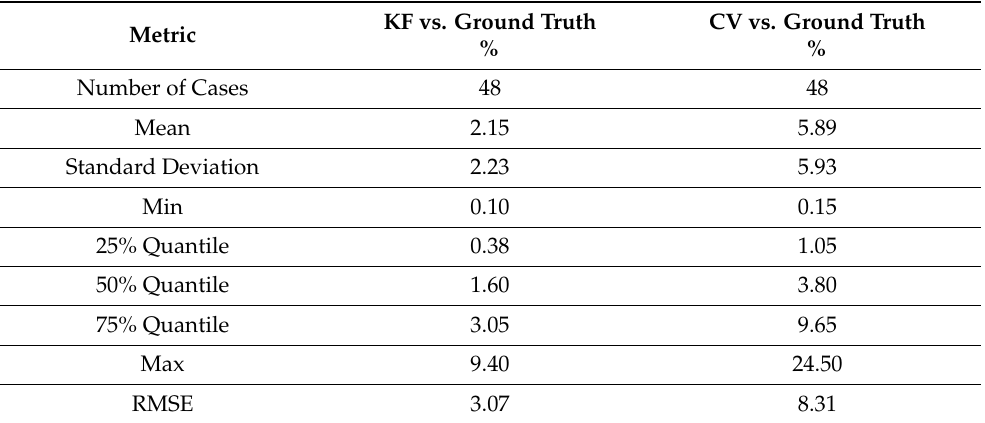
Table 3. Residuals of Instances with Superior KF Outcomes (Peak-Hour Case).